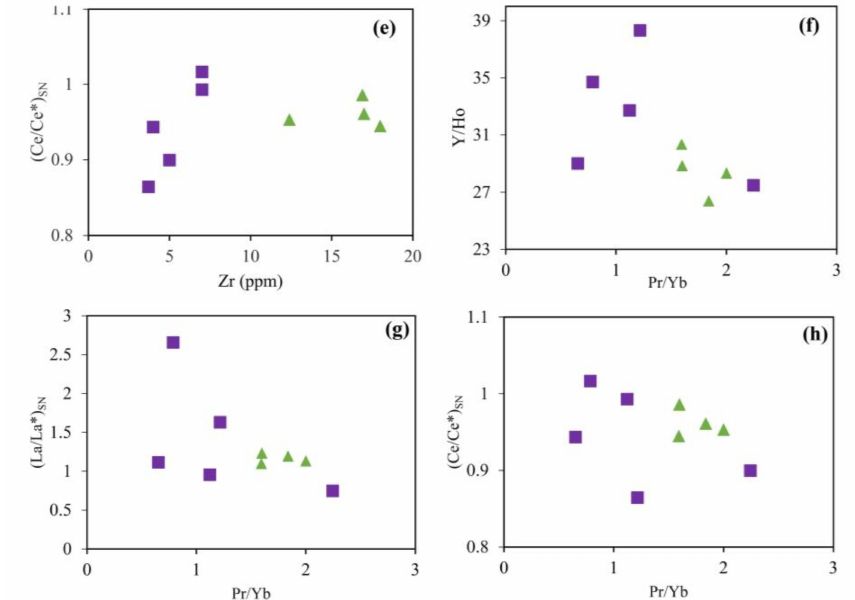
Figure 16. Detrital input assessment of the Anyouzok IFs: ( a ) Fe/Ti vs. Al/(Al + Fe + Mn). The curve represents the mixing of pelagic sediments (PC) with East Pacific Rise deposits (EPR); the approximate amount of EPR in the mixture [88] is indicated by the numbers in percentages. CU: Cyprus umber, UC: Upper continental crust, RS: Red sea hydrothermal deposits [53,89]; ( b ) Th/U vs. Zr; ( c ) Y/Ho vs. Zr; ( d ) (La/La*) SN vs. Zr; ( e ) (Ce/Ce*) SN vs. Zr; ( f ) Y/Ho vs. Pr/Yb; ( g ) (La/La*) SN vs. Pr/Yb; ( h ) (Ce/Ce*) SN vs.